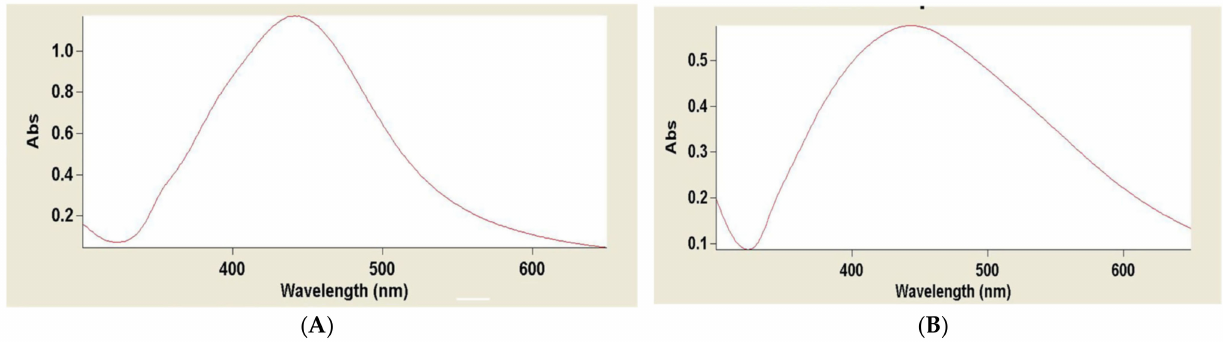
Figure 6. The UV-Vis spectra recorded for the reaction of Pomegranate peel ( A ) and Orange peel ( B ) with AgNO 3